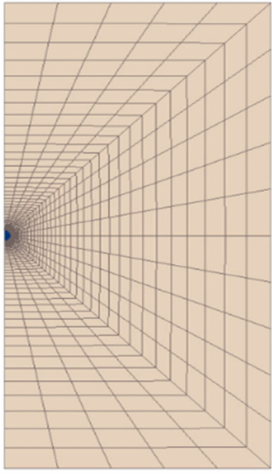
Figure 2. Schematic diagram of